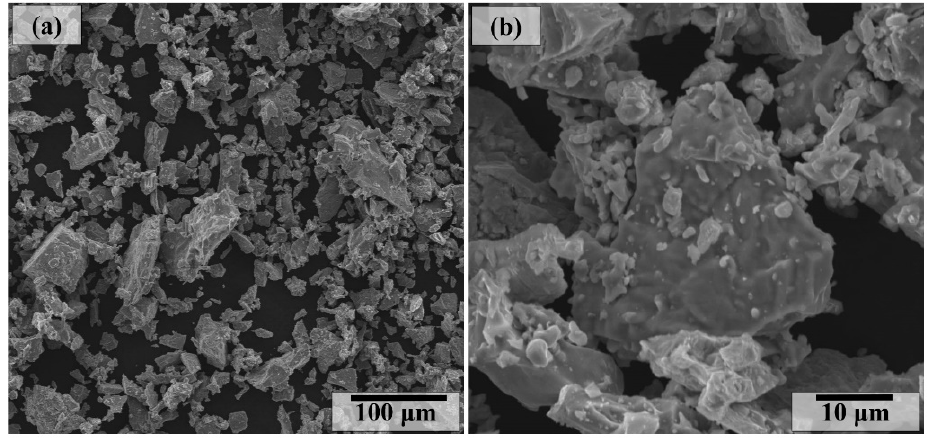
Figure 2. SEM images of Ti powder particles at low ( a ) and high ( b ) magnification indicating irregular morphology.